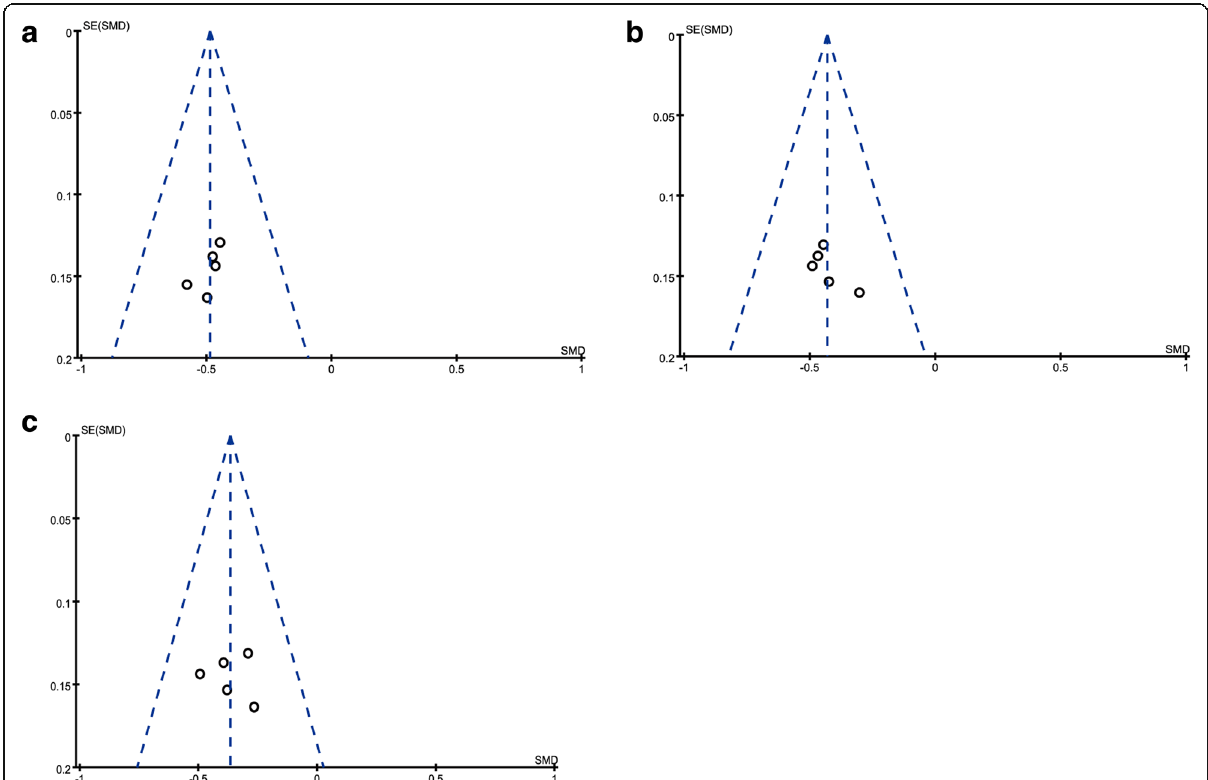
Fig. 5 Funnel plot of the meta-analysis showed no significant publication bias in the reduction of monthly migraine days. a weeks 1 – 4; b weeks 5 – 8; c weeks 9 – 12. SE = Standard error, SMD = Standardized mean